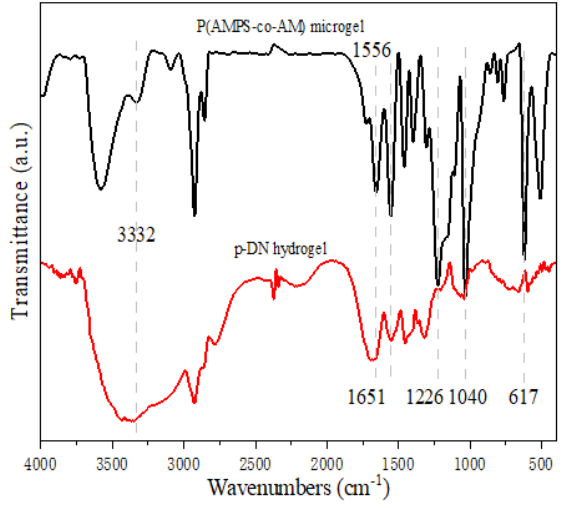
Figure 2. Infrared spectra of P(AMPS–co–AM) microgel and p–DN hydrogel.